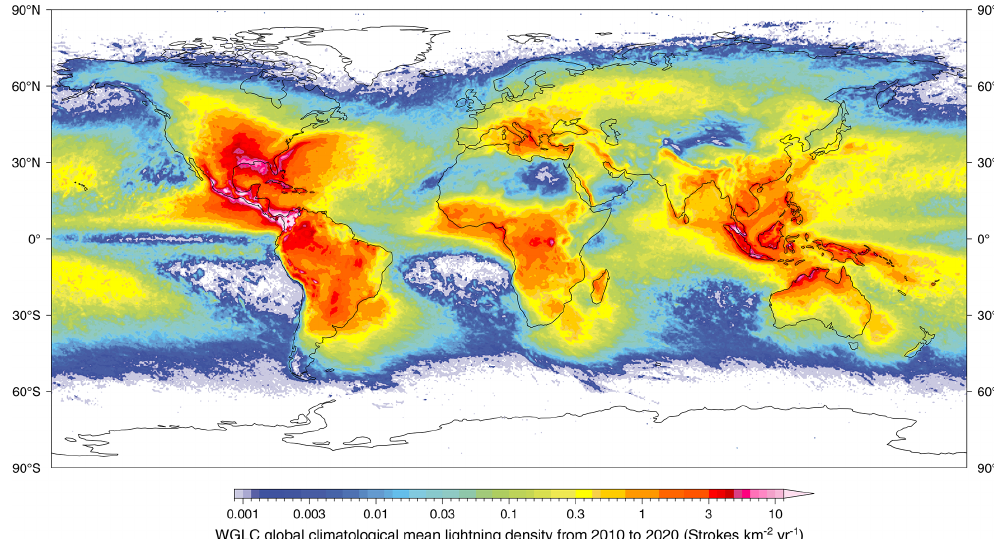
Figure 4. Climatological mean annual lightning stroke density (2010–2020).